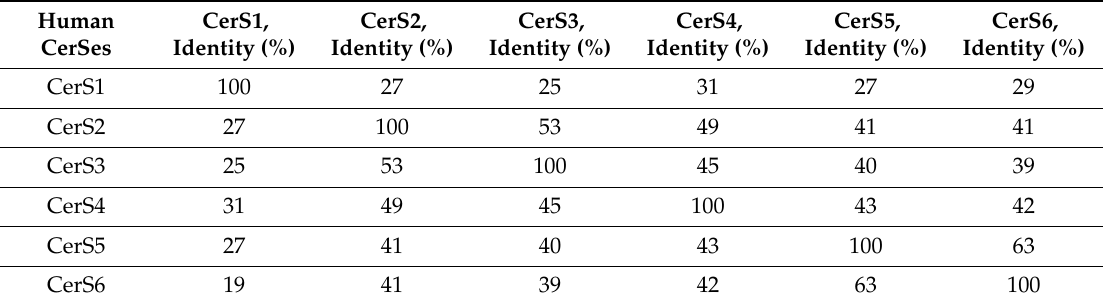
Table 3. Sequence identities (%) for human CERS1–6 enzymes. Three distinct human CERS sub-families were identified based on amino acid sequence comparison: CERS1, (22–27%); CERS2–4, (37–51%); and CERS5–6,